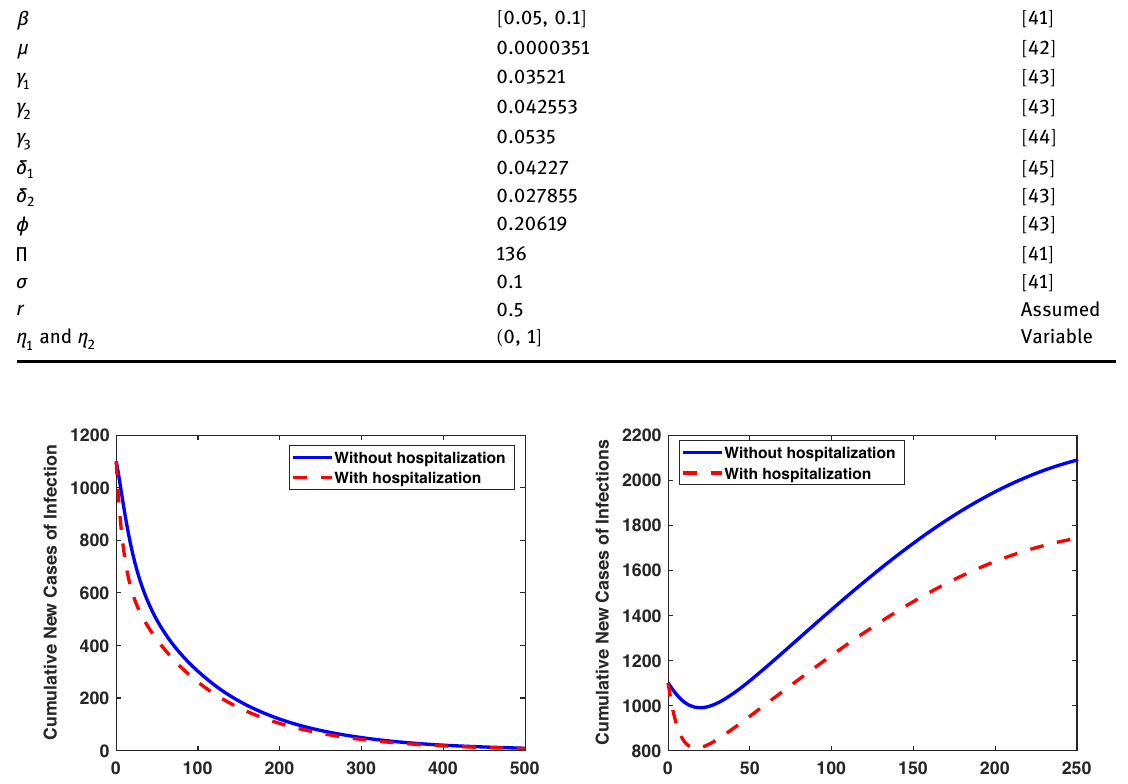
. ( Right ) The contour plots of the reproduction number > (cid:3) 1 0 2